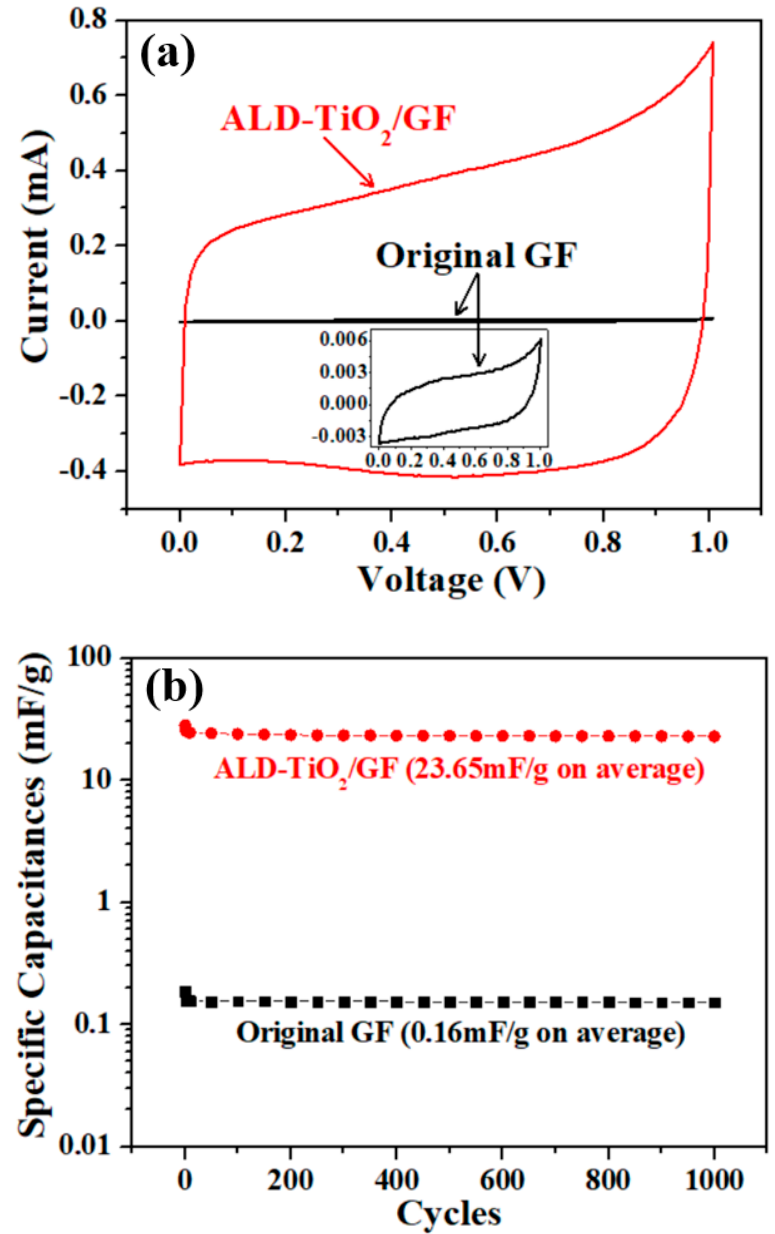
Figure 7. ( a ) Cyclic voltammetry (CV) curves of the original graphite felt (GF) and ALD-TiO 2 modified GF (ALD-TiO 2 / GF), the scan rate is 1 V / s. ( b ) Specific capacitances of original GF and ALD-TiO 2 / GF GF (ALD-TiO 2 /GF), the scan rate is 1 V/s. ( b ) Specific capacitances of original GF and ALD-TiO 2 /GF obtained from 1000 times CV obtained from 1000 times CV cycling-test.